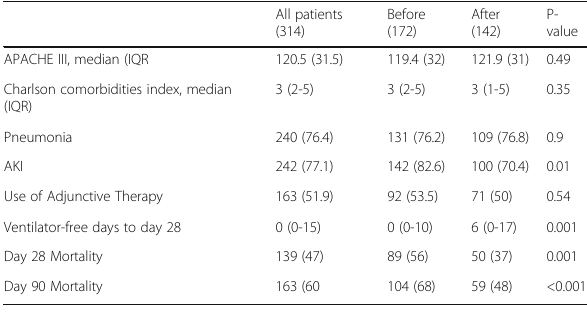
Table 2 (abstract 0002). Characteristics and outcomes after implementation of ARDS protocol in moderate- severe ARDS